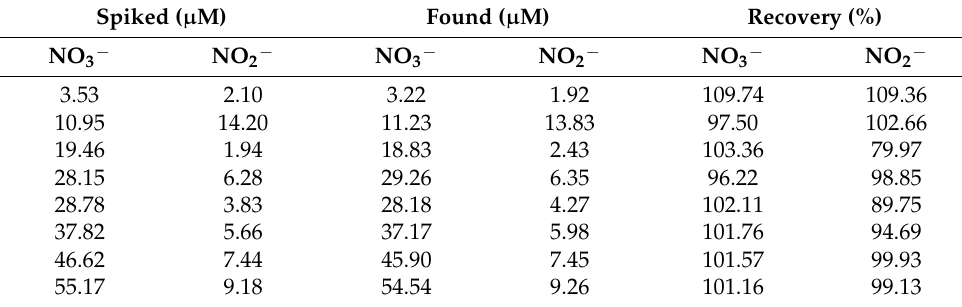
Figure 3. The relationships between the actual and predicted NO 3 − , NO 2 − and salinity of samples in prediction set using PLS2 model ( A – C ) and CLS model ( D – F ). Red dash lines indicate ratio of actual: predicted value = 1:1. Table 3. Recoveries of NO 3 − and NO 2 − in spiked seawater